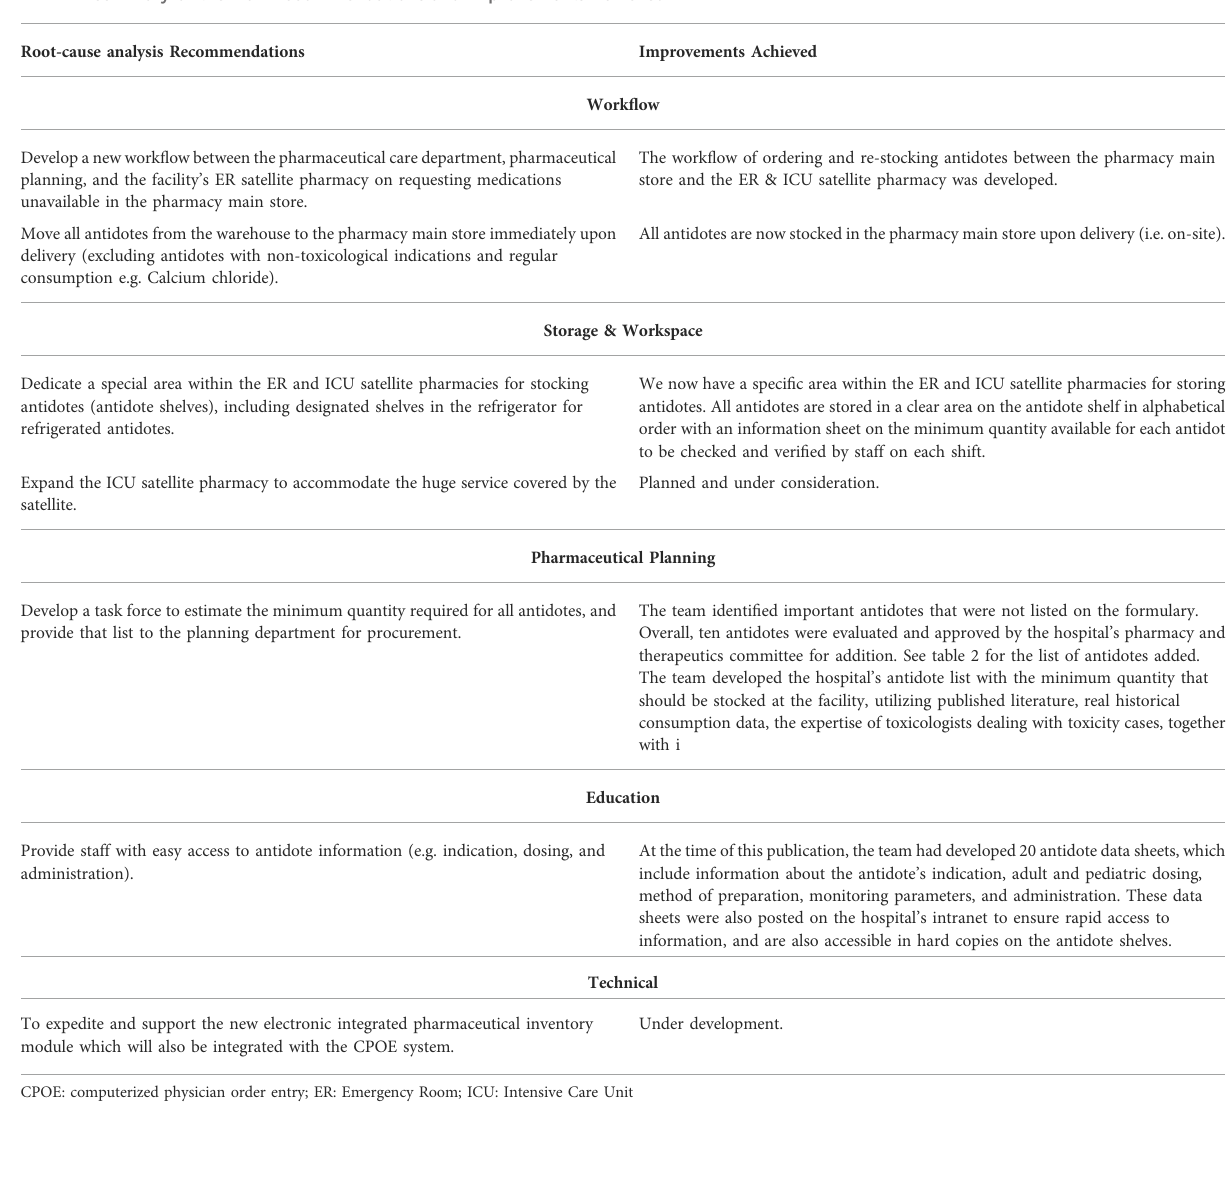
TABLE 1 Summary of the RCA Recommendations and Improvements